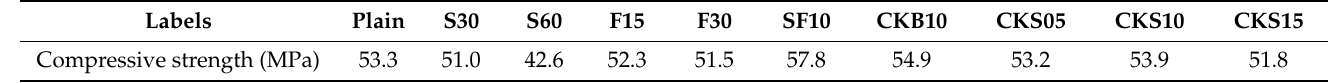
Table 3. Compressive strength of specimens at 28